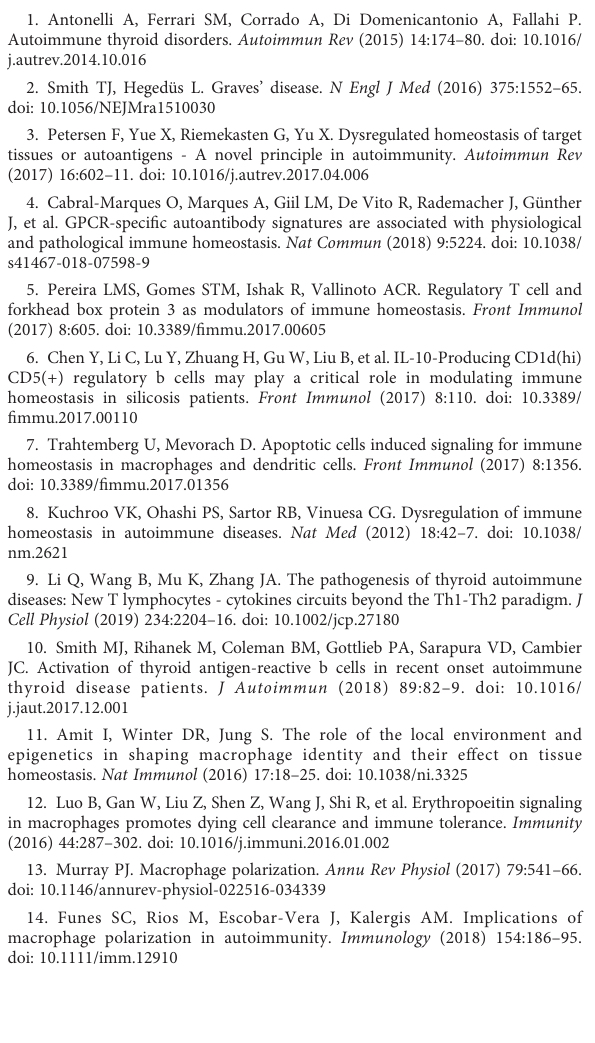
(A) Enrichment plots of human macrophage polarization gene sets in the GSEA analysis of human M1 polarization induced by IFN- g in GSE82227 (From left to right: M1 and M2; M1: ES=0.92 (P<0.001, FDR q <0.001; M2: ES=0.40, P=0.91, FDR q=0.91); (B) Enrichment plots of human